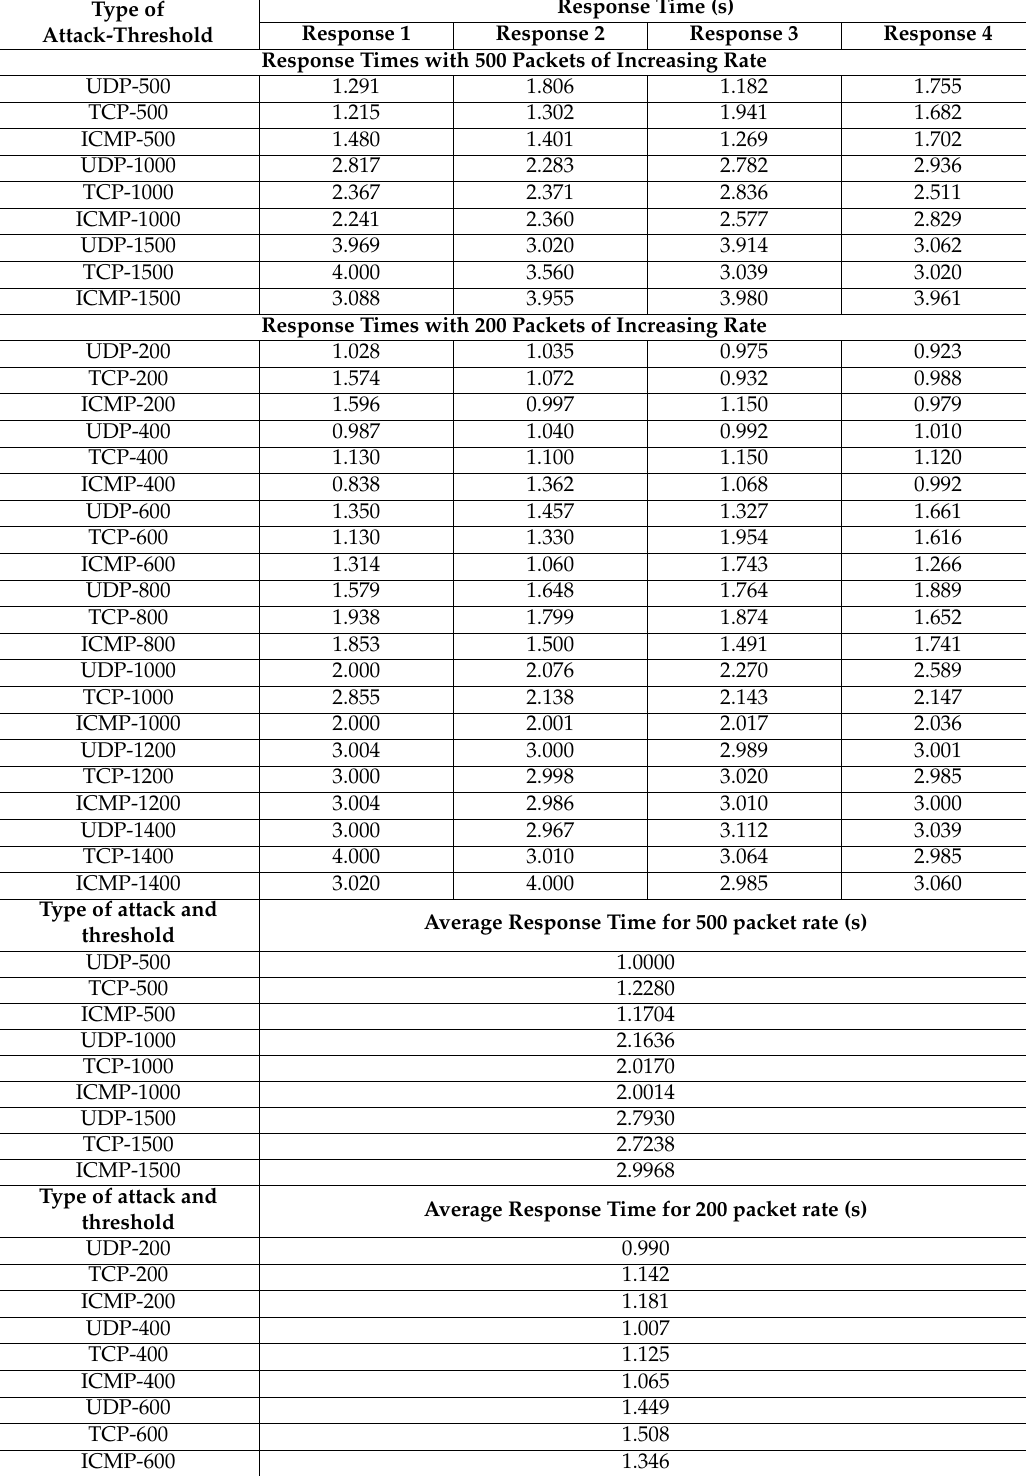
Table 1. Response times of the increasing rates of 200 and 500 packets and the average response times for 200 and 500 packet